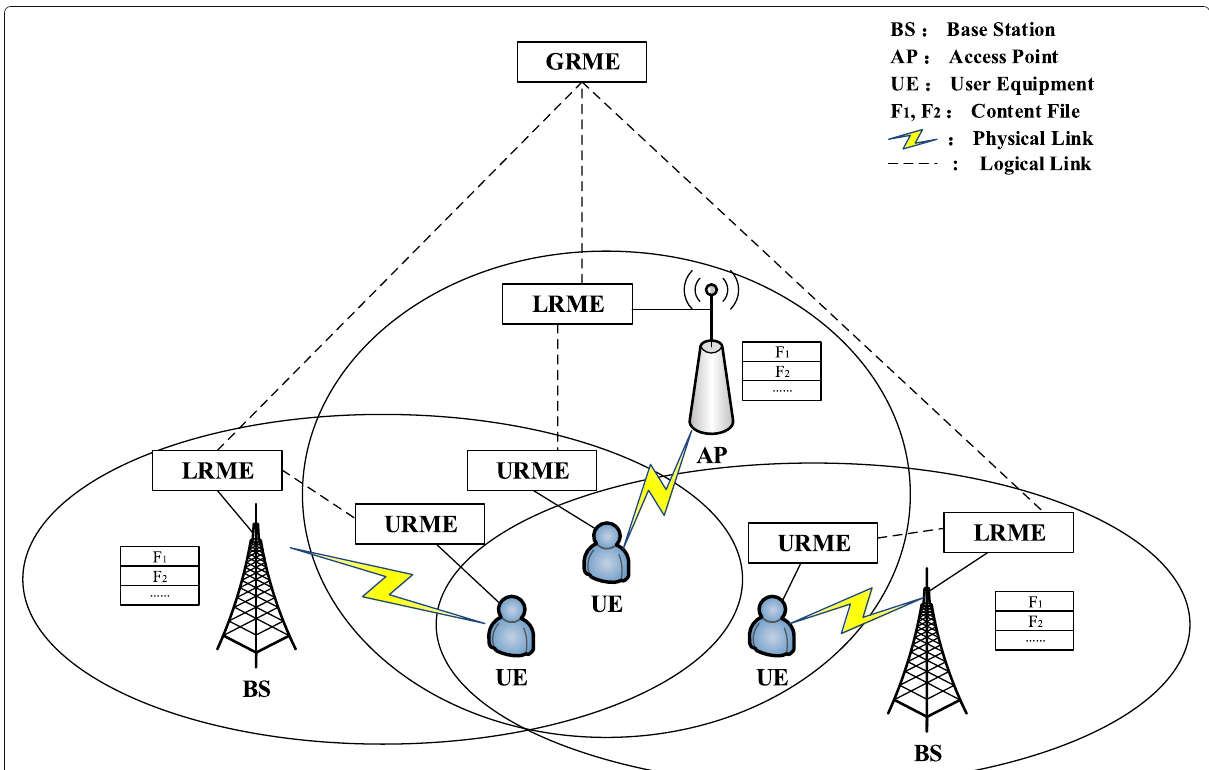
Fig. 2 Proposed joint resource management architecture. The proposed joint resource management architecture based on which the joint resource management scheme can be